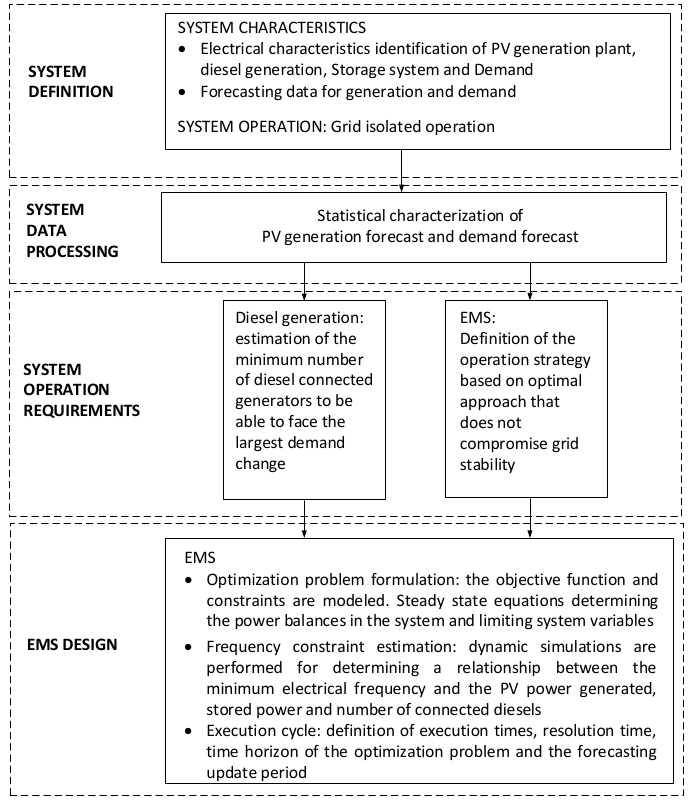
Figure 2. EMS design